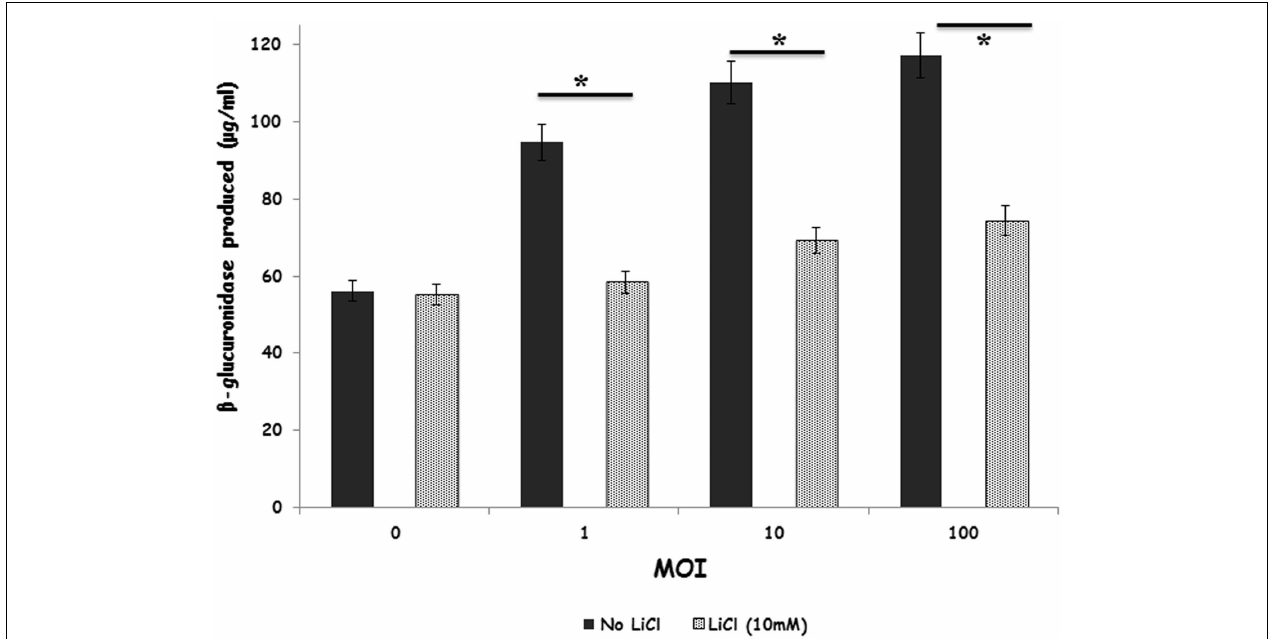
quadruplicate wells in a non-treated, black CoStar flat-bottom ELISA plate and incubated with 50 µ l of freshly prepared substrate (10mM 4-methylumbelliferyl- β -d-glucuronide, 0.1%Triton X-100 in 0.1M sodium acetate buffer) for 4h at 41°C.The reaction was stopped by adding 200 µ l of stop solution (0.05M glycine and 5mM EDTA; pH 10.4) to each well. Liberated 4-methylumbelliferone was measured fluorimetrically (excitation wavelength of 355nm and an emission wavelength of 460nm) with a GENios Plus Fluorescence Microplate Reader (TECAN US Inc., ResearchTriangle Park, NC, USA).These values were converted to micromoles of 4-methylumbelliferone generated using a standard curve of known concentrations. * p ≤ 0.01.